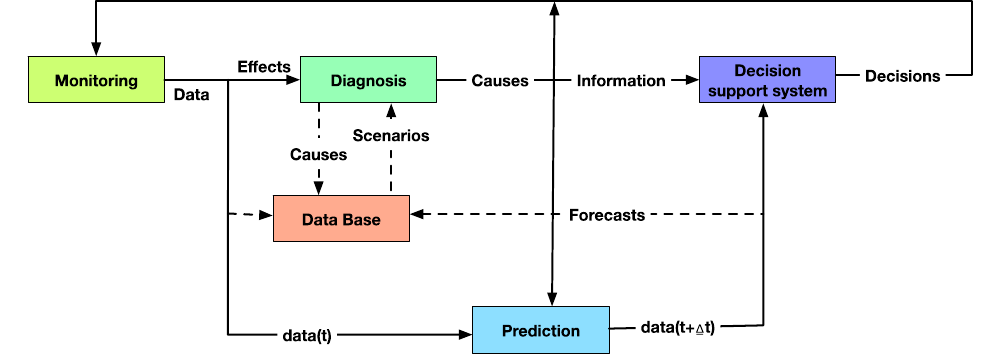
Figure 9. Block diagram of the microgrid software.